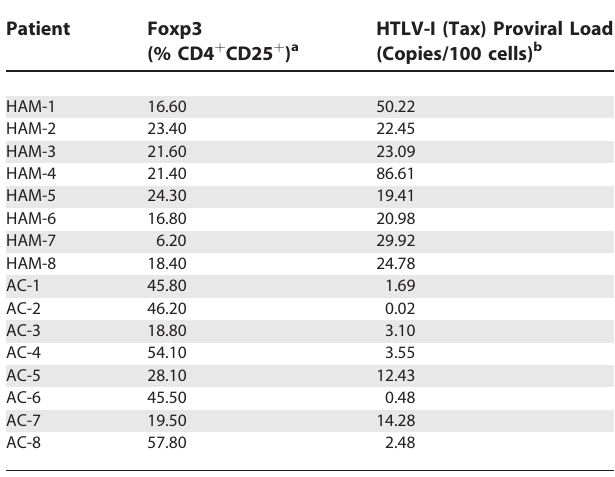
Table 1. Expression of Foxp3 in CD4 þ CD25 þ T Cells in HTLV-I- Infected Patients